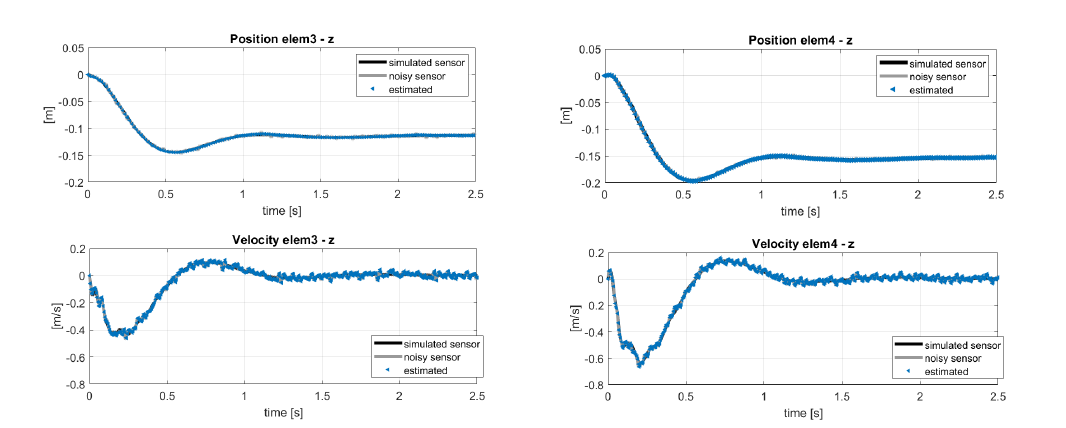
Figure 7. Estimation of the states used as sensors. Reference noisy data.